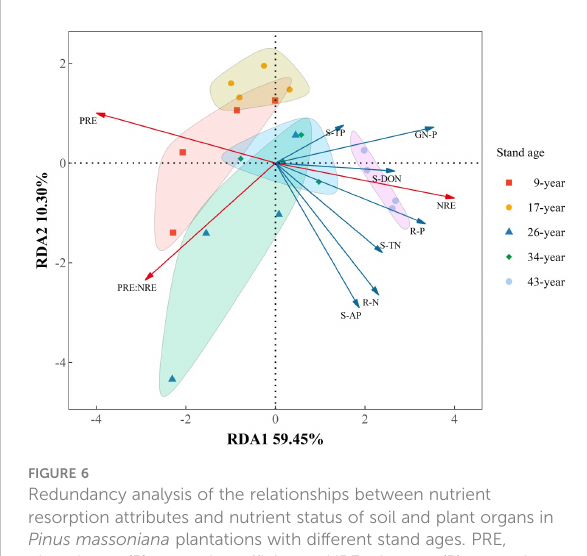
FIGURE 6 Redundancy analysis of the relationships between nutrient resorption attributes and nutrient status of soil and plant organs in Pinus massoniana plantations with different stand ages. PRE, phosphorus (P) resorption ef fi ciency; NRE, nitrogen (P) resorption ef fi ciency; S-TN, soil total N; S-TP, soil total P; S-DON, soil dissolved organic N; S-AP, soil available P; GN-P, Green needle P; R-N, root N; R-P, root P.